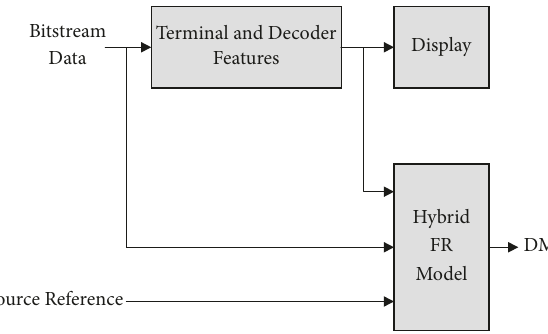
Figure 26: Block diagram of hybrid FR